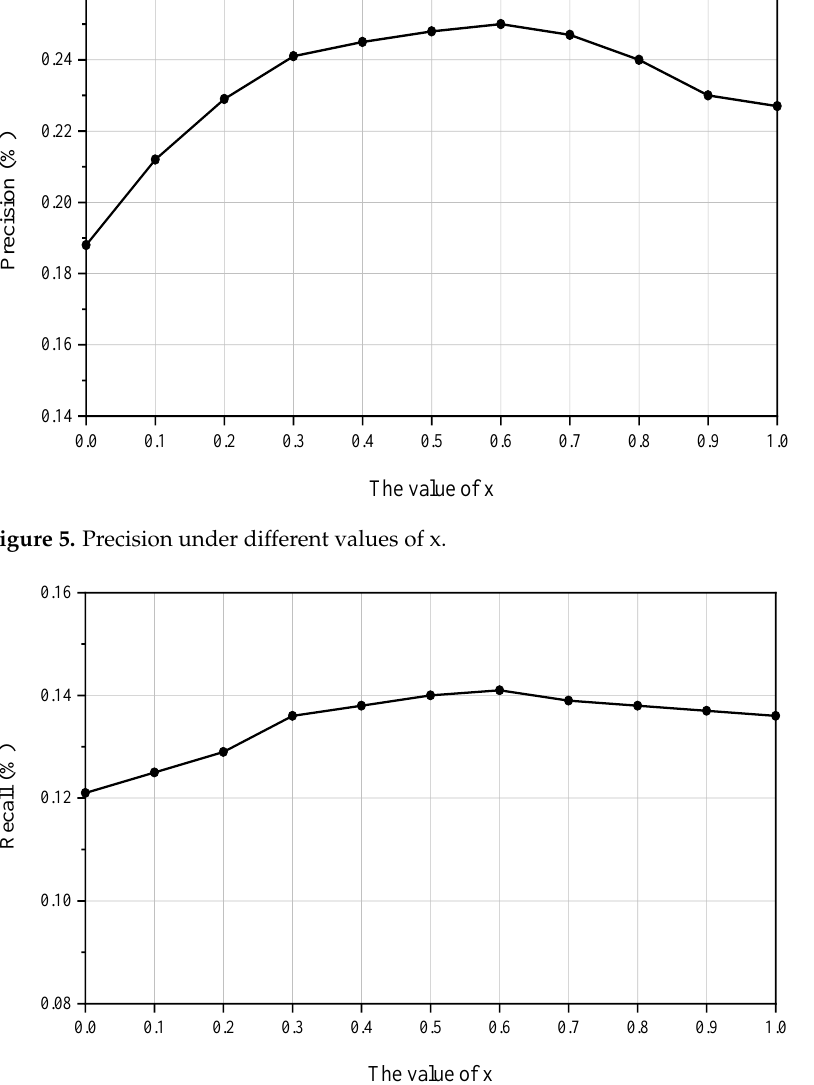
Figure 6. Recall under different values of x.